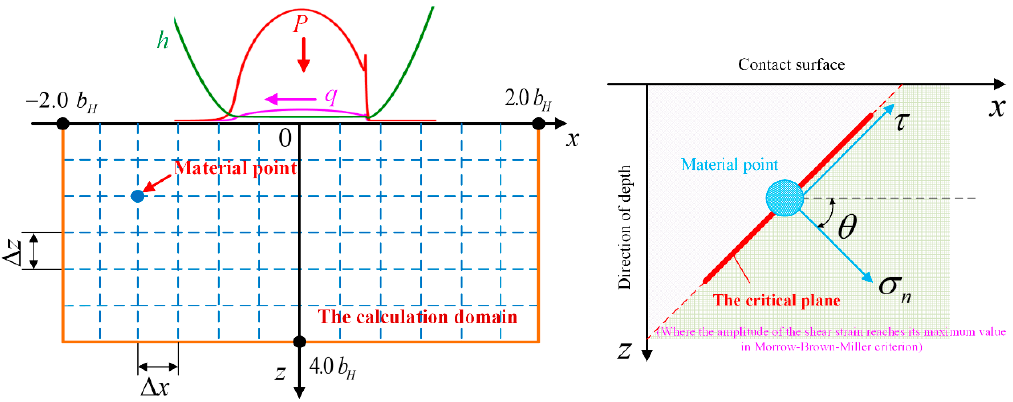
Figure 10. The schematic diagram of the calculation domain and the critical plane of RCF.